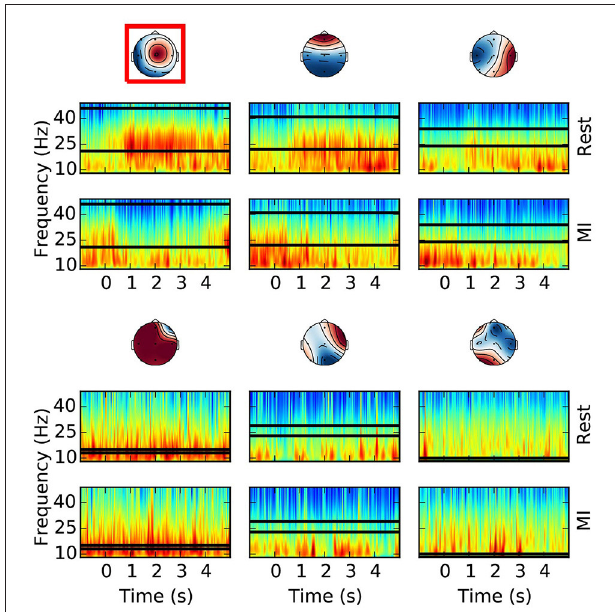
FIGURE 4 | Offline optimal frequency band and CSP filter selection. For each CSP filter the spectrograms of the rest (top) and MI (bottom) conditions are shown. The selected optimal frequency band is depicted with two horizontal lines over the time frequency representation. The optimal CSP filter, selected among the first 3 and last 3 columns of the unmixing matrix, is surrounded by a red box. The color scale of the time-frequency representation is equalized for each column (i.e., CSP), and for the selected CSP it is between 5.4 and 8.9 with unit 10 log 10 ( µ V 2 / Hz ). All the other CSPs have comparable color ranges. This example is taken from a subject performing foot motor imagery. It is possible to appreciate how the optimal frequency band and CSP filter contain the most discriminative (i.e., rest vs. MI) spectral